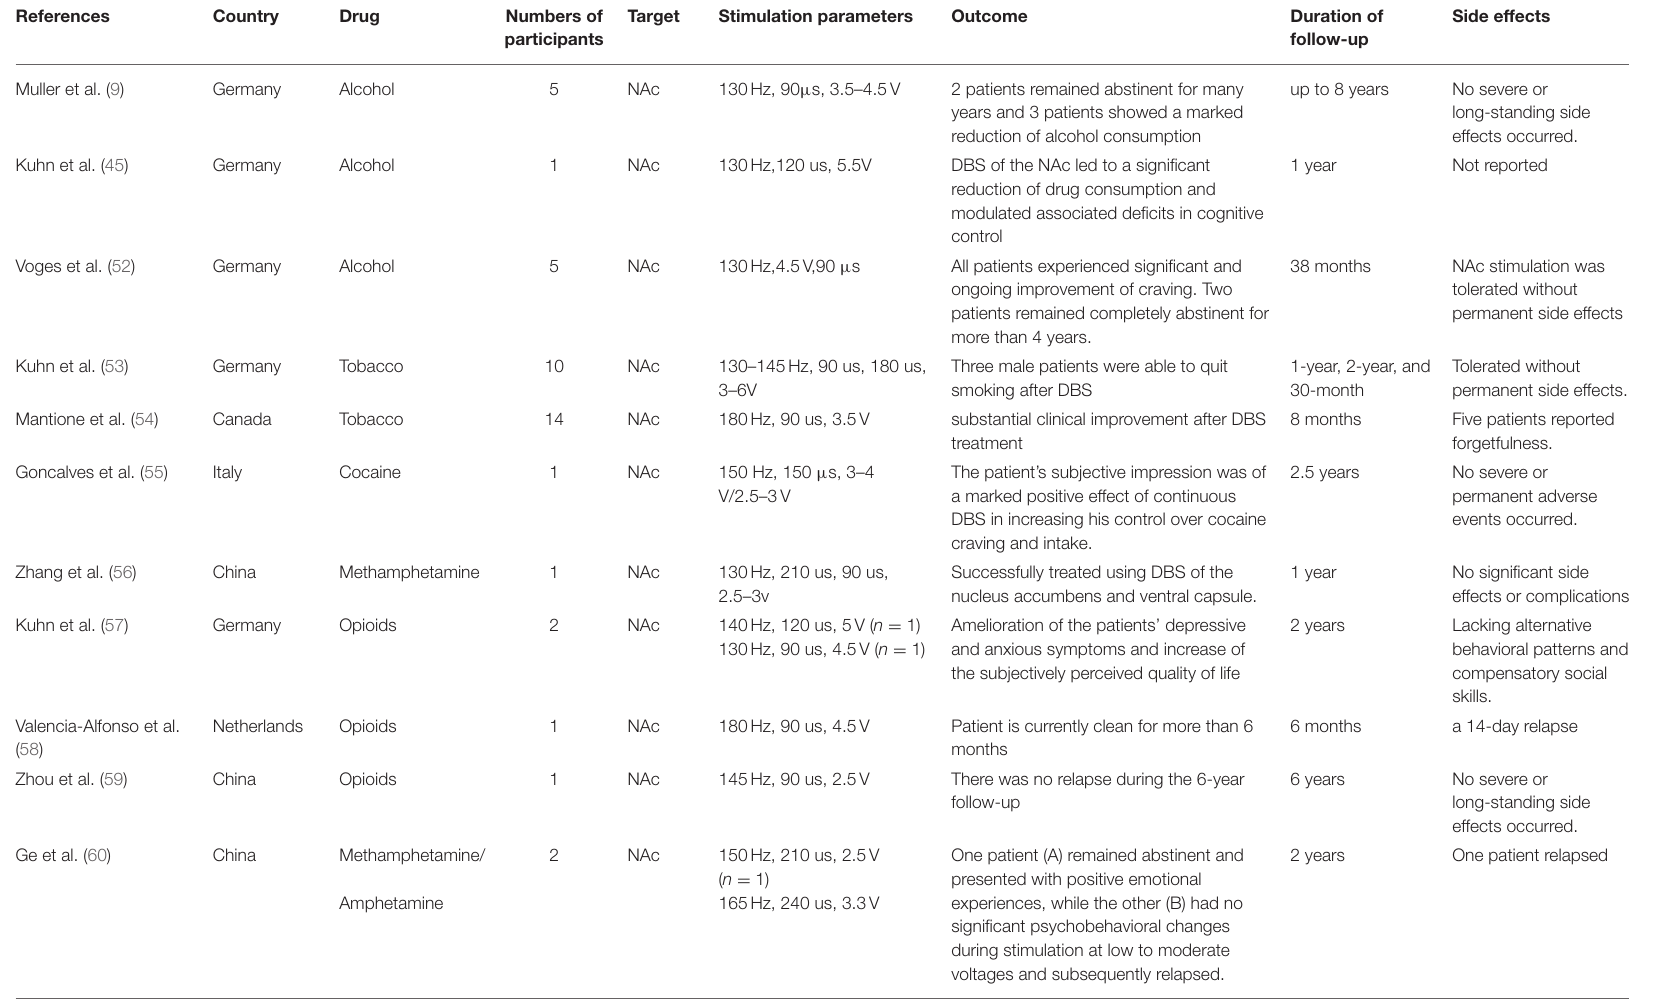
TABLE 1 | Human DBS trials for